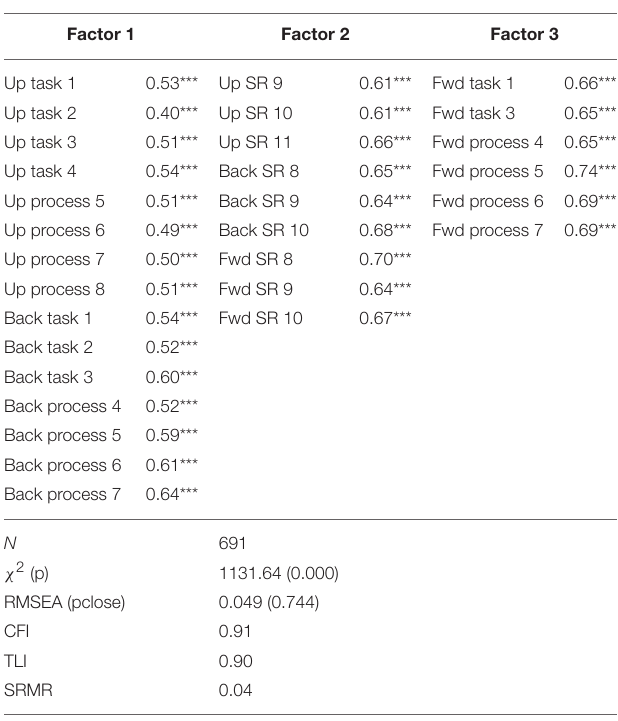
TABLE 4 | Standardized factor loadings and model fit statistics for the confirmatory factor